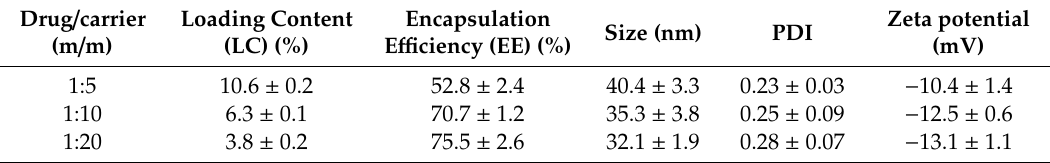
Table 3. Structural and drug loading properties of DOX / BSA NPs. Data are presented as mean ± SD, n =